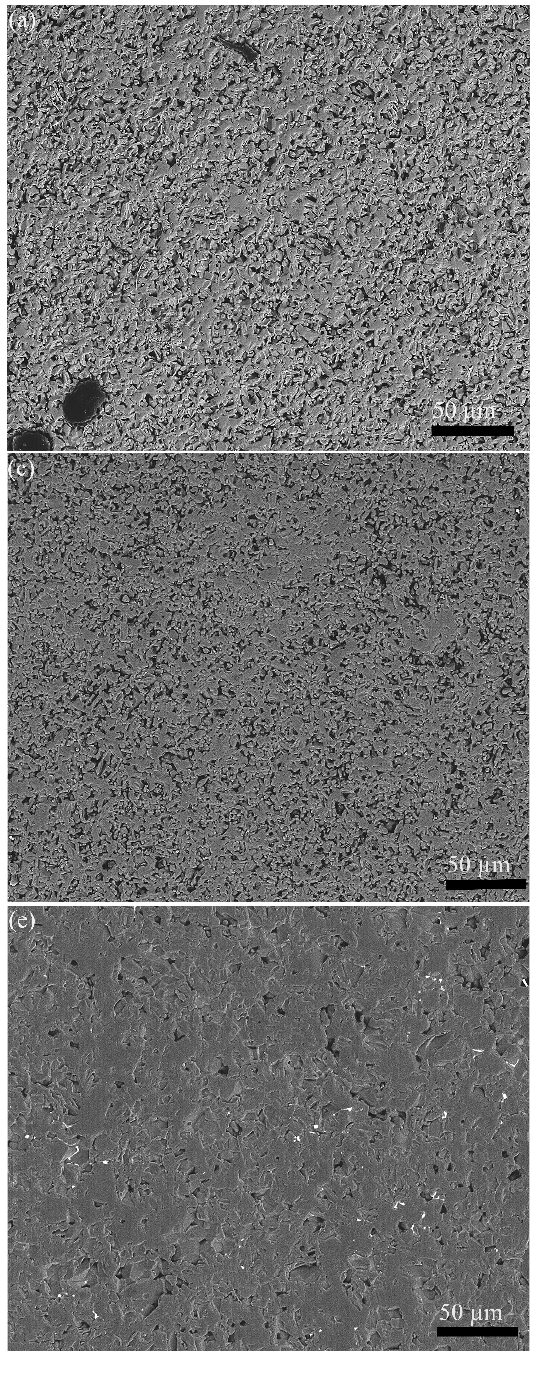
Figure 6. Polished surfaces of Al 2 O 3 ceramics fabricated from various alumina powders: ( a ) VM 1 h; ( b ) VM 3 h; ( c ) VM 5 h; ( d ) DBDPM 1 h; ( e ) DBDPM 3 h; and ( f ) DBDPM 5 h.